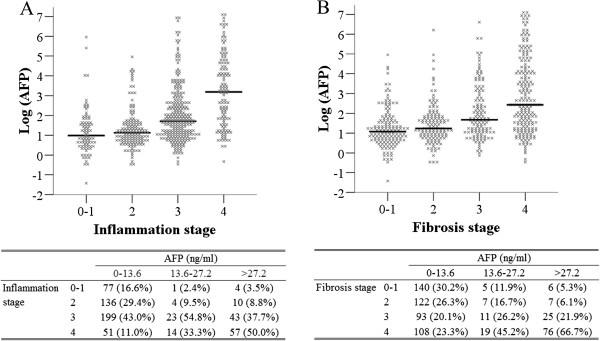
The distribution of AFP vs. inflammation stage (A) and fibrosis stage (B). The upper limit of AFP normal range is 13.6 ng/ml, patients were divided into three groups by AFP levels according to normal (0–13.6), 1–2 upper limit of AFP normal range (13.6-27.2), and more than 2 upper limit of AFP normal range (>27.2).